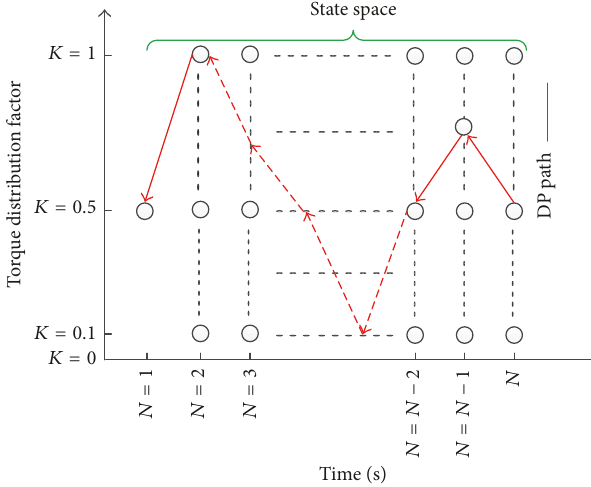
Figure 5: Schematic diagram of dynamic programming control